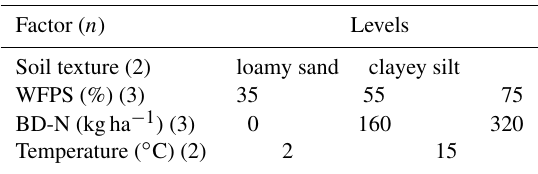
Table 1. The examined factors soil texture, water-filled pore space (WFPS) and amount (i.e. concentration) of nitrogen (N) applied with biogas digestate (BD) with their respective levels applied in the present study, resulting in 18 treatments with three replicates each. The temperature was manipulated consecutively during the